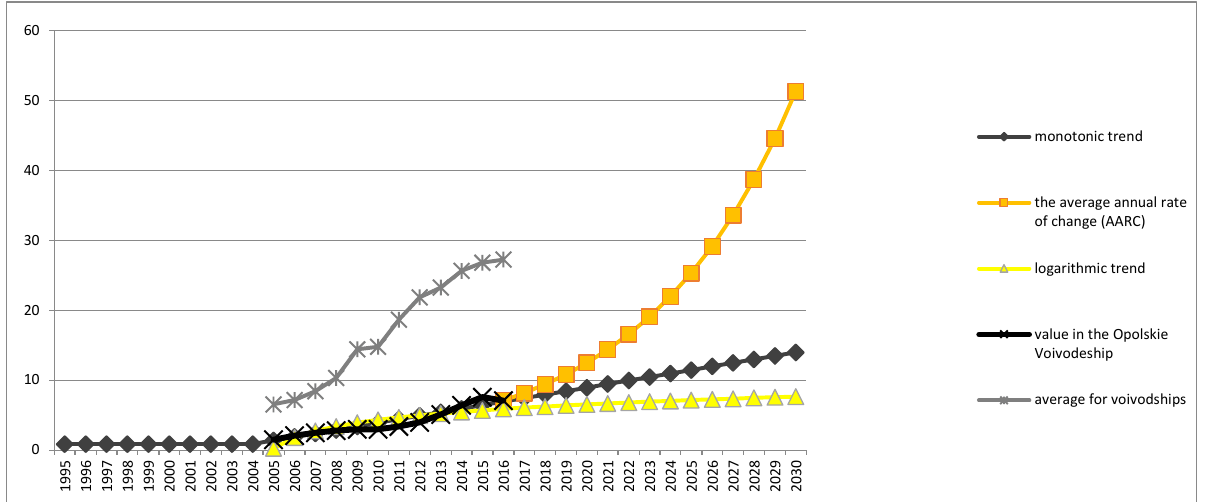
Figure 3. RES usage degree in electricity consumption (%). Source: own elaboration. Another determinant of the issue is the low share of people using the gas system (%), amounting to 41.90 in 2016 with a national average of 49.48, which also means that the trend remains below the national average. In 2030, the indicator will amount to 42.80. The impact of this factor is strengthened by further causes, i.e., the low share of people connected to gas networks and the limited availability of gas fuel with a rural population higher than the national average. A separate issue is the gas pollutant emis- sion from particularly troublesome plants, including the CO2 emission per km 2 of sur- face area (in tons per year per km 2 of surface area), which amounted to 1368.00 in 2017 and was substantially higher than the national average of 792.56. In 2030, the indicator will reach 1403.15 if the current trend continues (Figure 4). On the other hand, dust pol- lutant emissions from particularly troublesome plants, including the CO2 emission per km 2 of surface area (in tons per year per km 2 of surface area), amounted to 11,606.00 in 2017 and was over twice as high as the national average of 5874.43. In 2030, the indicator will reach 45,267.76.